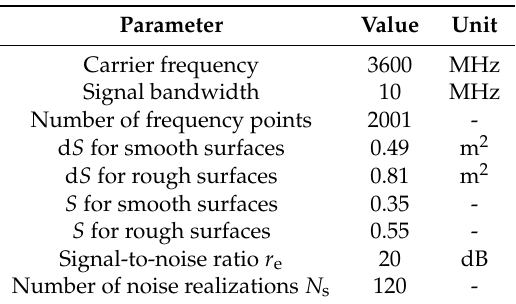
Table 1. The parameters used for the verification of the propagation graph simulation of the proposed performance-evaluation